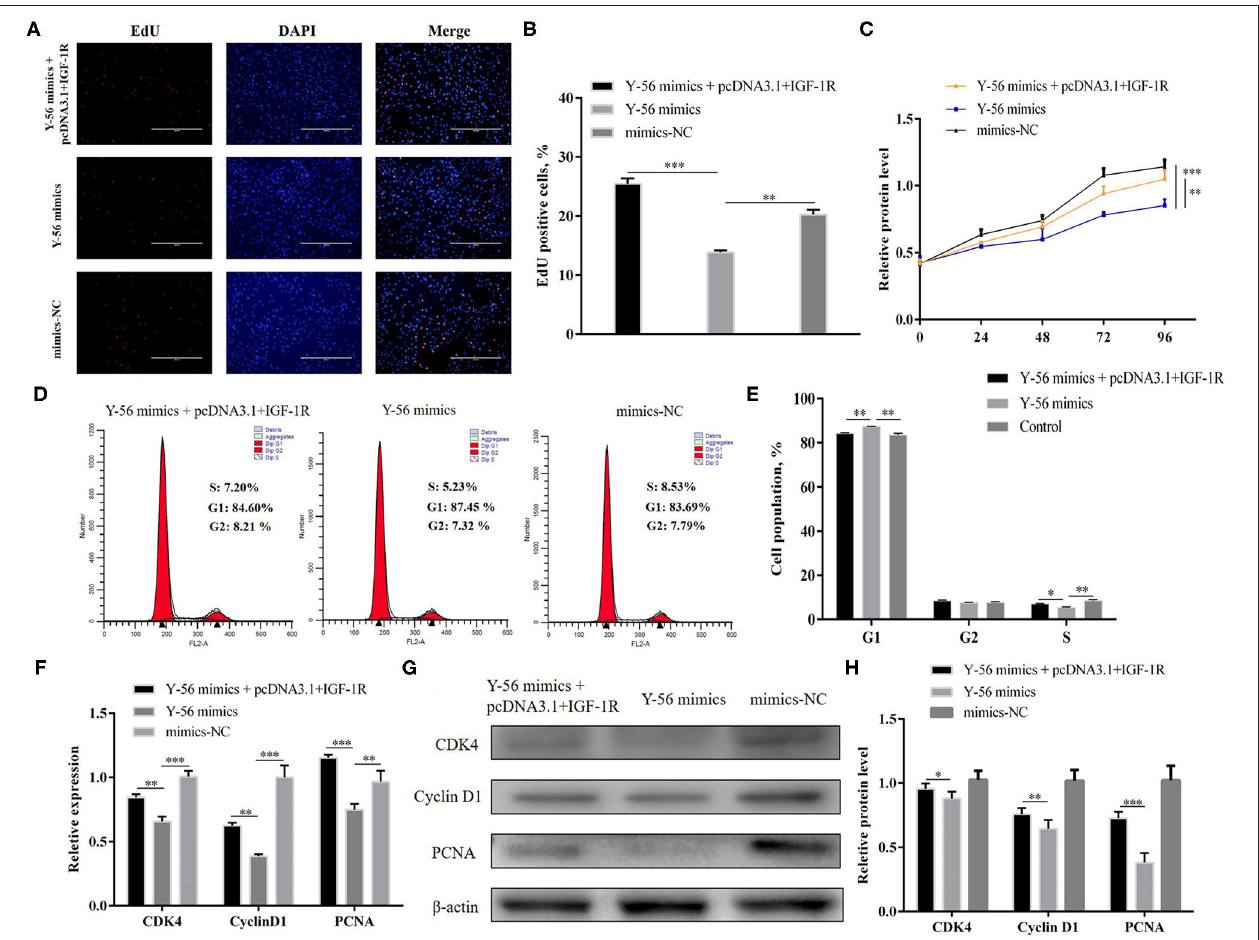
FIGURE 7 | IGF-1R reverses the inhibitory effect of Y-56 on PSCs. (A,B) EdU staining assay of PSCs after the co-transfection of IGF-1R and Y-56 mimics. (C) CCK-8 assay of PSCs after the co-transfection of IGF-1R and Y-56 mimics. (D,E) Flow cytometry data and statistical results of cell cycle analysis after the co-transfection of IGF-1R and Y-56 mimics. (F–H) . MRNA and protein expression of cell cycle marker genes after the co-transfection of IGF-1R and Y-56 mimics in PSCs. Results are shown as mean ± SEM, and the data are representative of at least three independent assays. Independent sample t -test was used to analyze the statistical differences between groups (* P < 0.05, ** P < 0.01, and *** P <